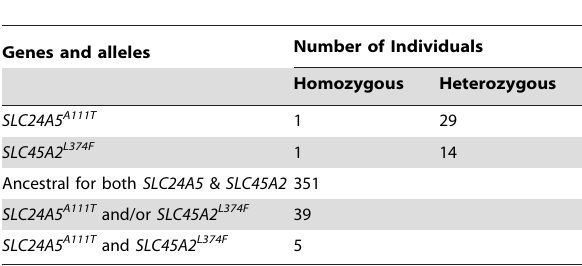
Table 3. Senoi genotype combinations for SLC24A5 and